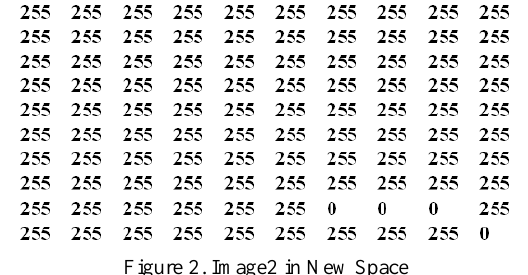
Figure 2. Image2 in New Space